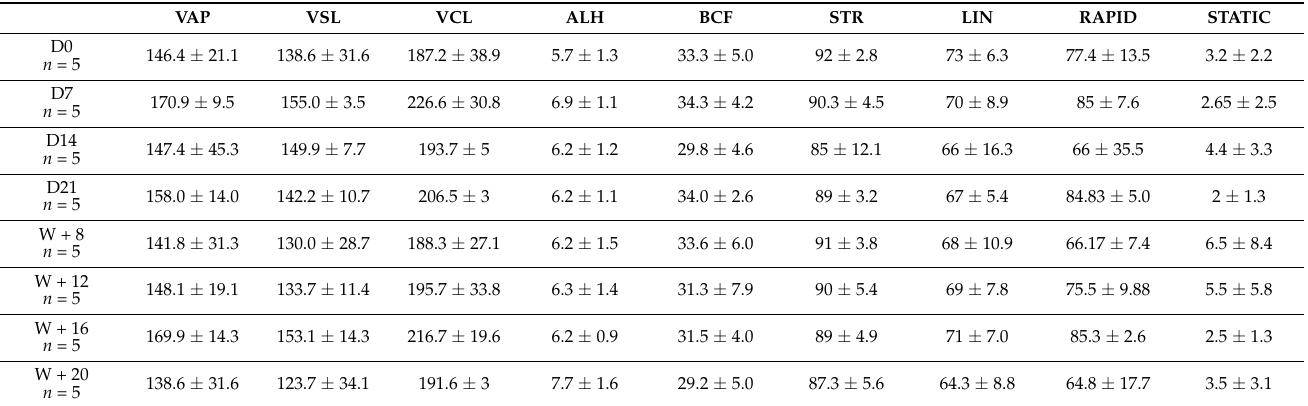
Table 2. Characteristics of sperm motility in the II sperm fraction samples collected from dogs in control group I (negative control- healthy stud dogs) compared to the results from day 0 ( n = 5). Results are presented as mean ± SD.